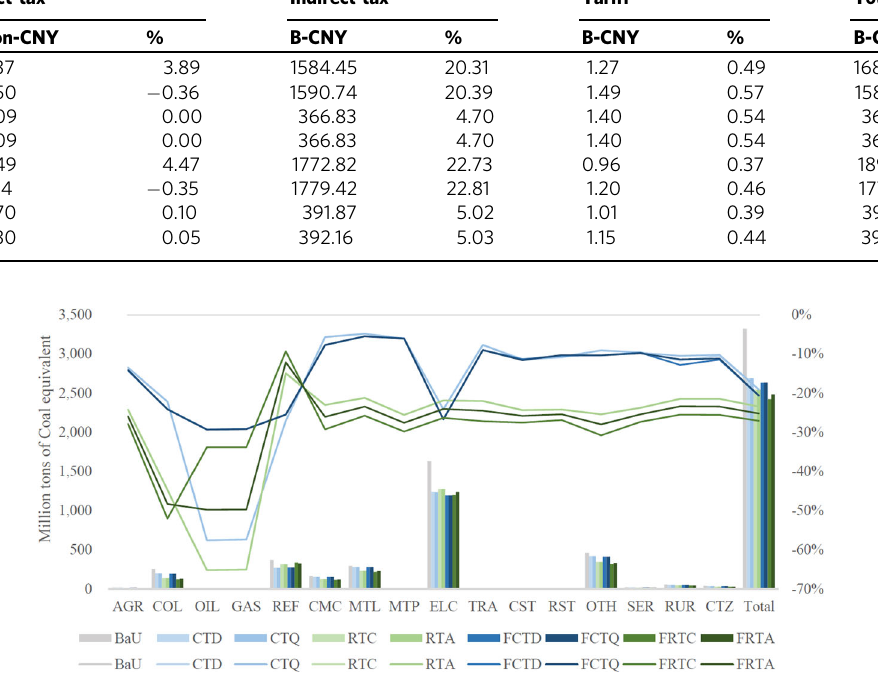
Fig. 10 Coal consumption in 2030. Blue bars/lines are scenarios imposing carbon taxes, and green bars/lines are scenarios imposing resource taxes. Deeper colors represent free market condition in these scenarios. Please refer to Table 2 for industry abbreviations.